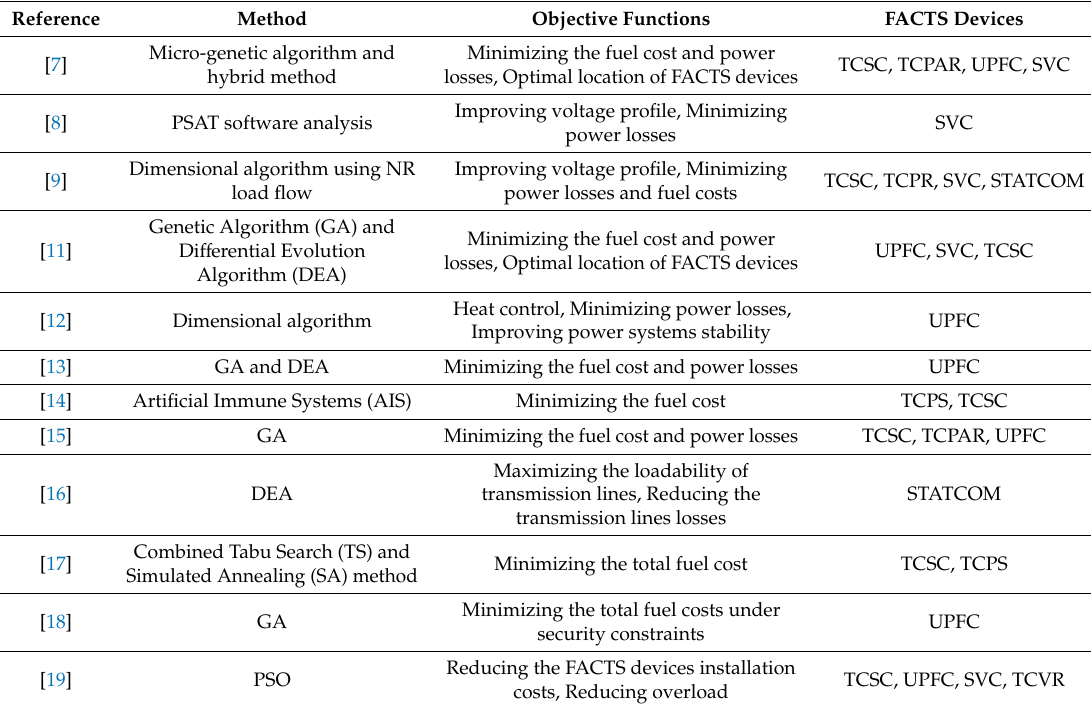
Table 2. Di ff erent methods to model the random behavior of wind power